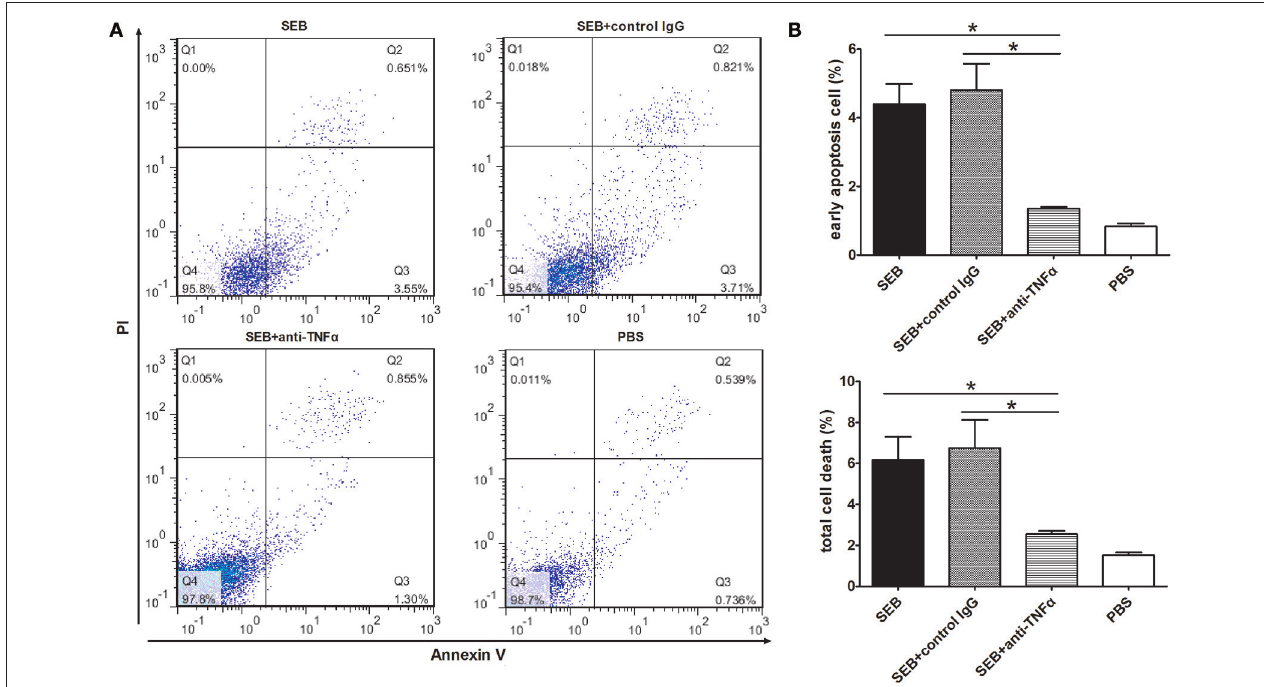
FIGURE 6 | Anti-TNF α neutralization reduced the SEB-induced apoptosis. (A) THP-1 cells (2 × 10 5 per well in 24-well-plates) were treated with 20 µ g/ml (24 µ l/well) SEB or 24 µ l/well PBS for 36h. For the neutralization group, 5 µ g/ml anti-TNF α or an isotype control IgG was added 30min before the SEB treatment was administered. Apoptosis was measured through Annexin V/PI staining and flow cytometry. (B) Quantitatively analyzed data are presented as means ± S.D . ( n = 3), *represented P < 0.05.